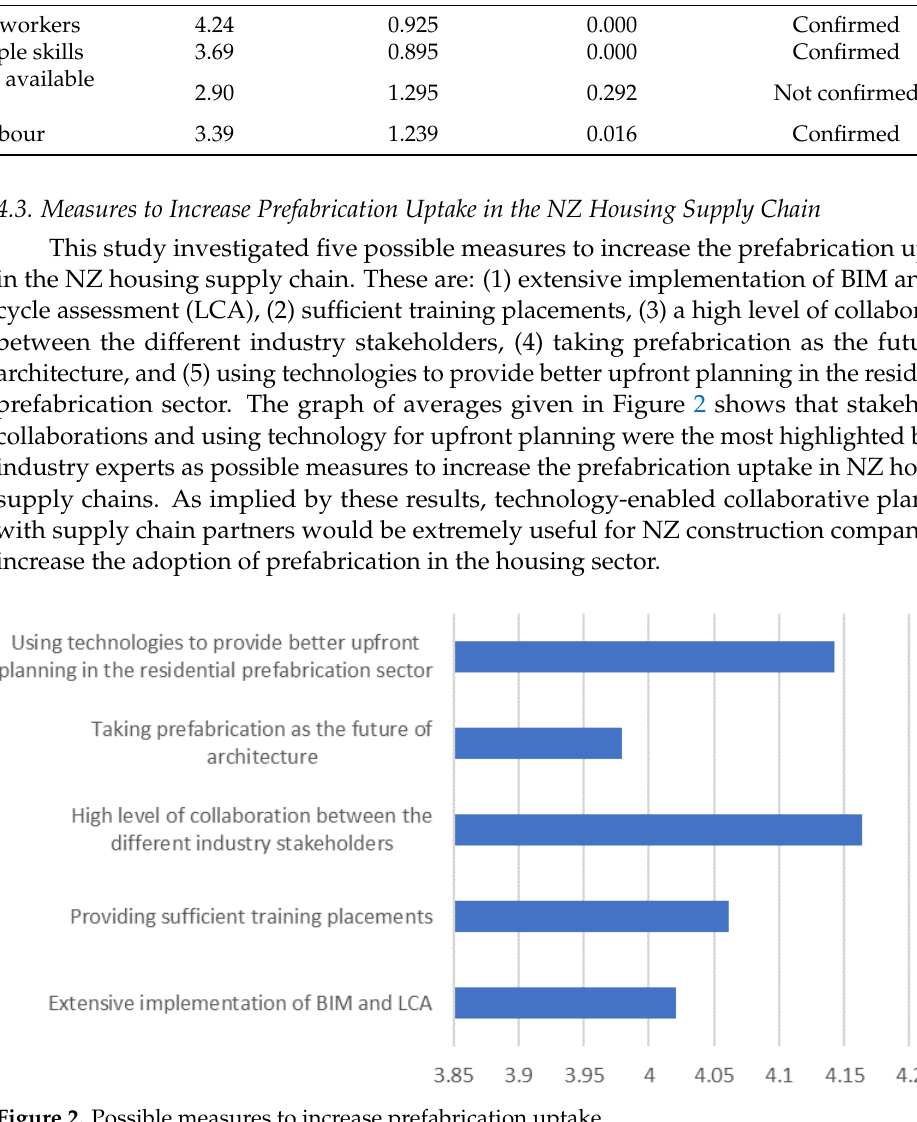
Figure 2. Possible measures to increase prefabrication